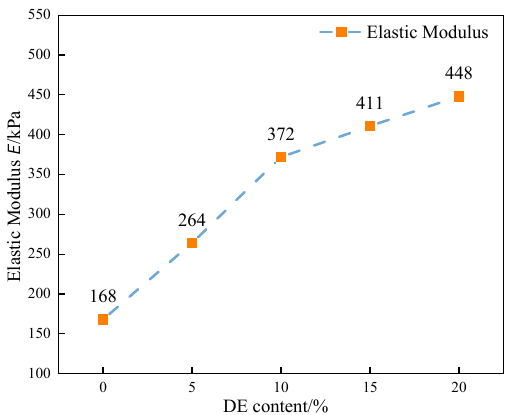
Figure 5. The elastic modulus of coastal cement soil specimens modified with different amounts of diatomite.